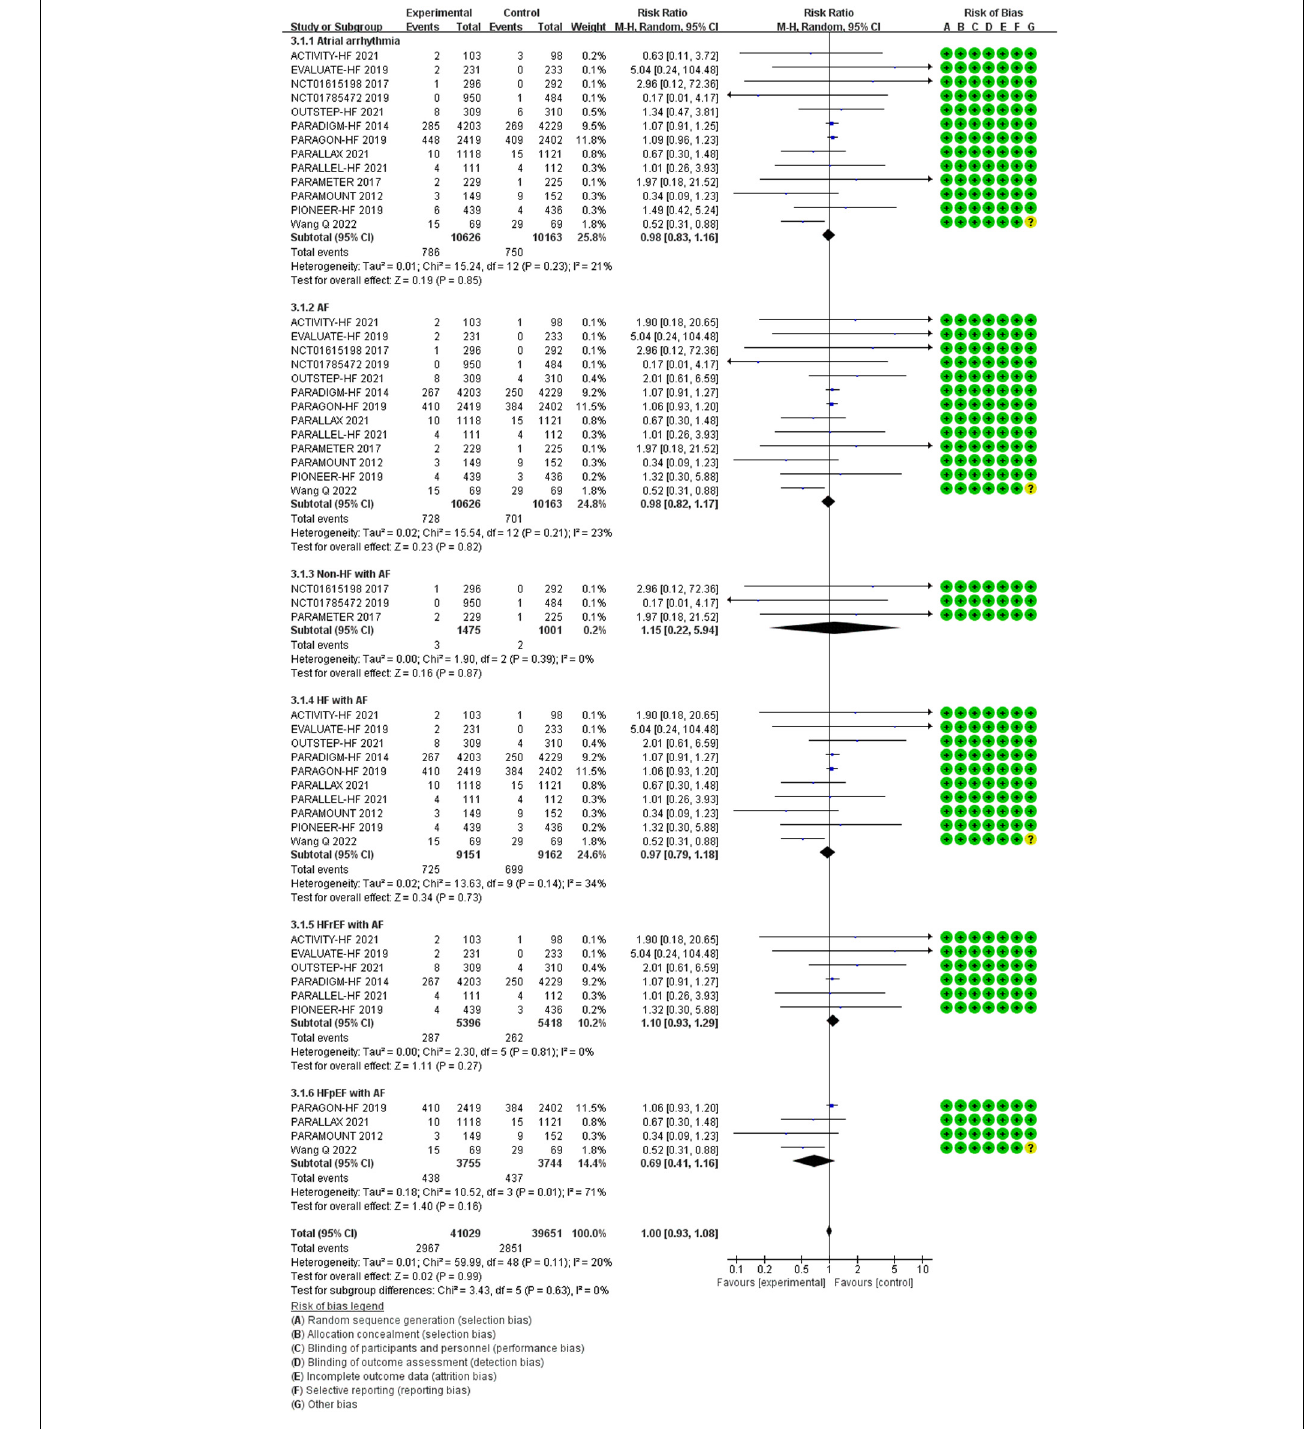
FIGURE 6 | The efficacy of SV compared to ACEI/ARB on atrial arrhythmias.